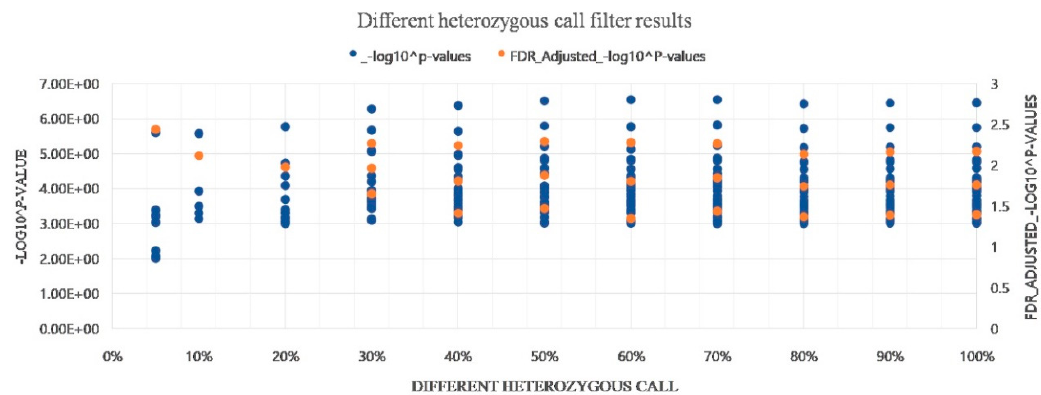
Figure 7. Different heterozygosity rates to filter genotype data and different significance cut-off thresholds used to assess the effect of the SNPs on seed aspect ratio.